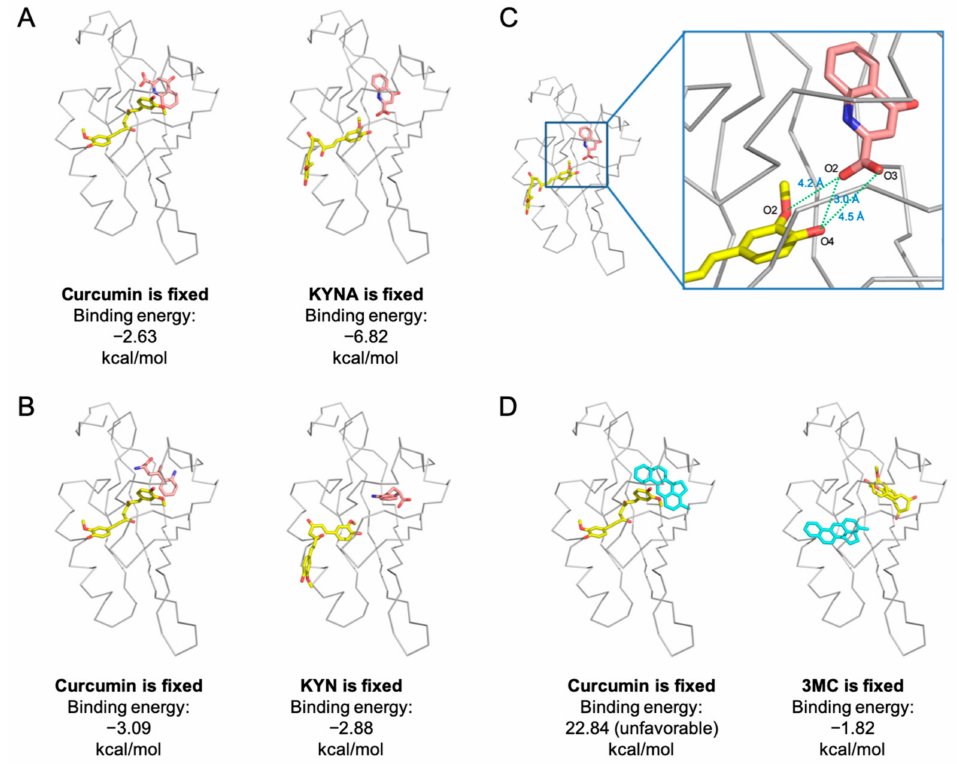
Figure 6. Curcumin and interactions of the bound ligands. AhR is represented in gray; the environ- ment of the ligand-binding cavity is shown for the equilibrated model colored by curcumin in yellow, 3MC in blue, and KYNA and KYN in pink. ( A ) Modeling co-existence of curcumin and KYNA in different binding sequences. ( B ) Modeling co-existence of curcumin and KYN in different binding sequences. ( C ) Modeling studying AhR binding to curcumin and KYNA. The O2 and O4 positions of curcumin formed hydrogen bonds (green dash line) with the O2 and O3 of KYNA. ( D ) Modeling co-existence of curcumin and 3MC in different binding sequences. Note that the curcumin may be able to co-exist on AhR with KYNA or KYN, and may block 3MC binding onto